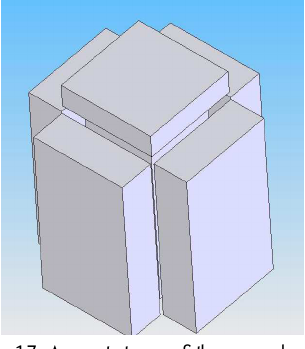
Fig. 17. A prototype of the new